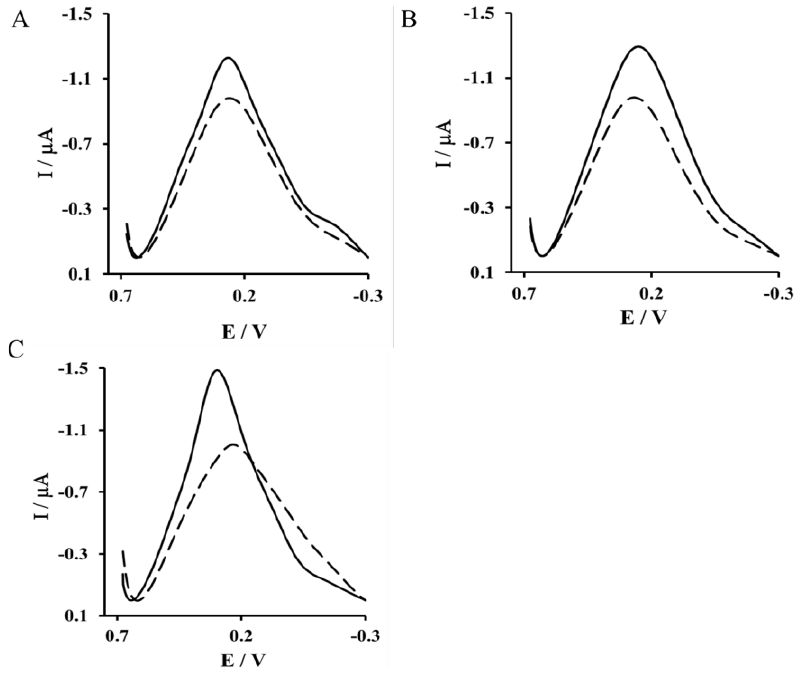
Figure 2. Osteryoung square wave voltammograms of a gold electrode modified by NAC/DPTA–Cu(II) (solid line) and after immobilization of: ( A ) RAGE VC1 natural domain; ( B ) RAGE VC1 deleted domain; and ( C ) RAGE C2 domain (dashed lines). Measurement conditions: 0.1 M KCl, scan rate100 mV·s −1